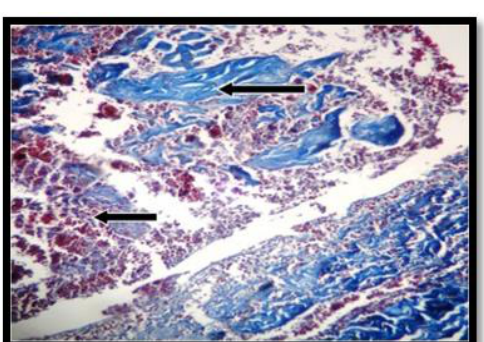
Figure, 4: BP-treatment group at 2 nd week post implantation, shows a multifocal MNCs aggregation (long arrow) consist mainly of macrophages and lymphocyte with proliferation of fibroblast producing collagen fibers (H&E stain, 100X) .